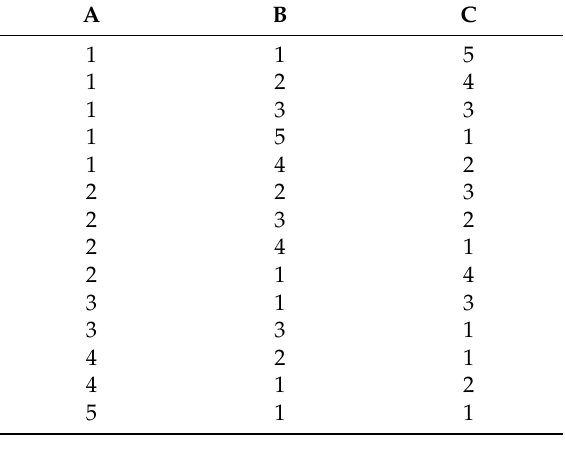
Table 1. Combination of all branch connections.